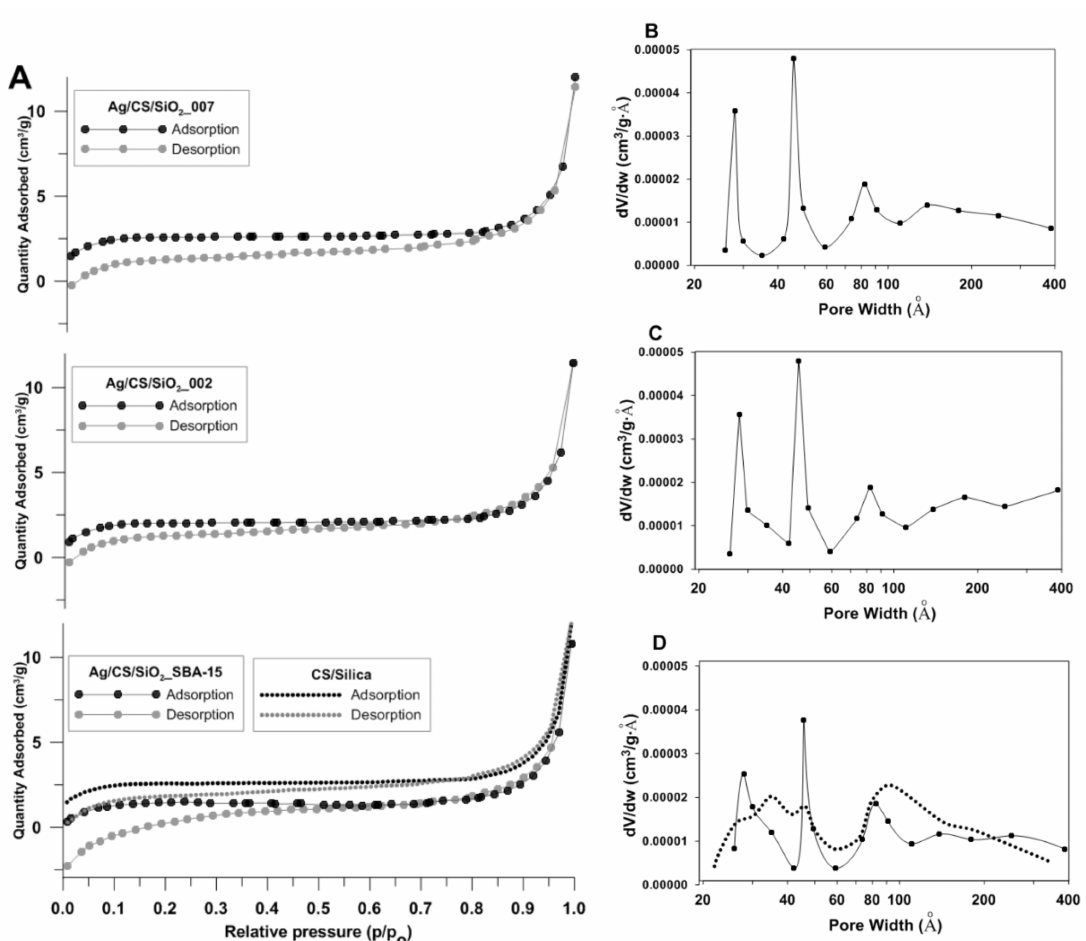
Figure 5. ( A ) Nitrogen adsorption-desorption isotherms plots of Ag / CS / silica nanofiber composites at 77 K. ( B – D ) Porosity distributions by the Barrett–Joyner–Halenda (BJH) model were calculated from the adsorption branch of the isotherms. Note: Dotted lines refer to a CS / silica sample used as a